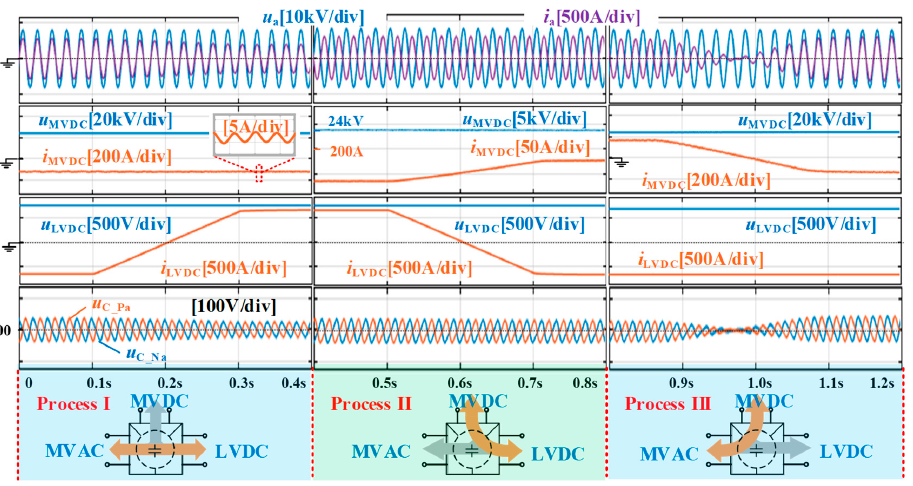
Figure 7. Dynamic simulation results of proposed three-port PET.